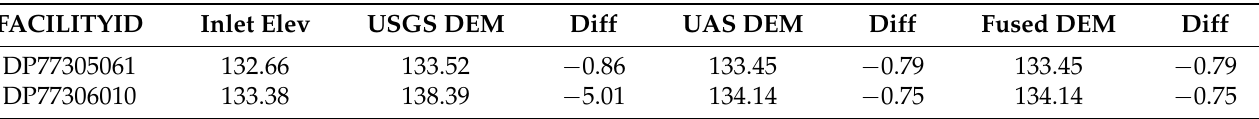
Table A3. Details report from surveyed stormwater inlet rim elevation used for DEM z-axis